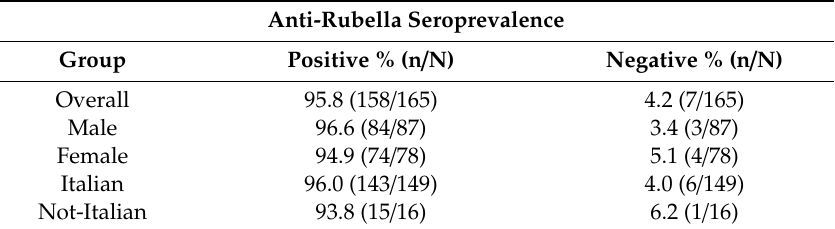
Table 1. Anti-rubella seroprevalence in the enrolled population. (n / N: number of subjects / total).